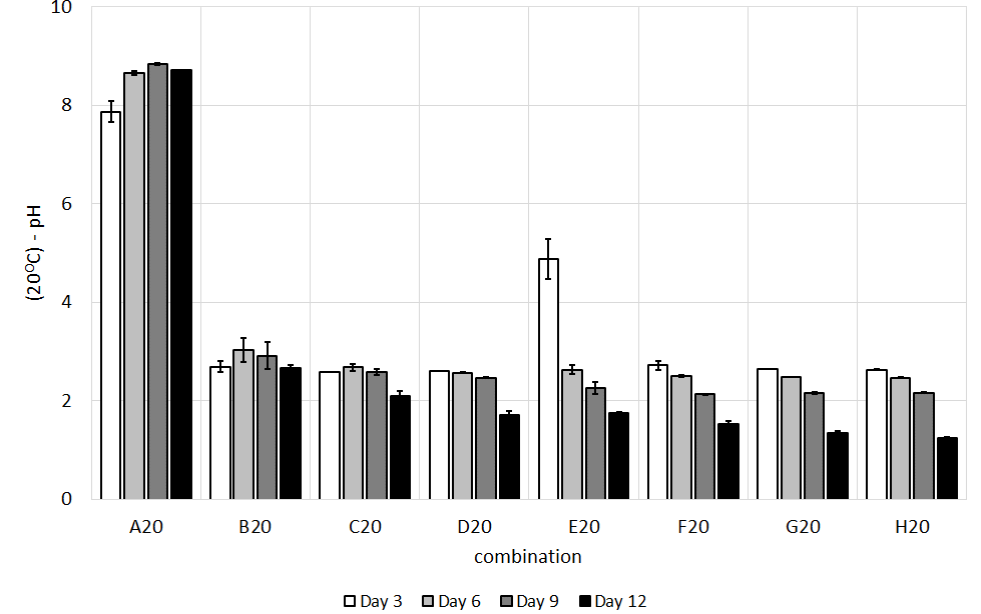
Figure 2. Changes in pH of bacteria culture samples incubated at 20 °C.